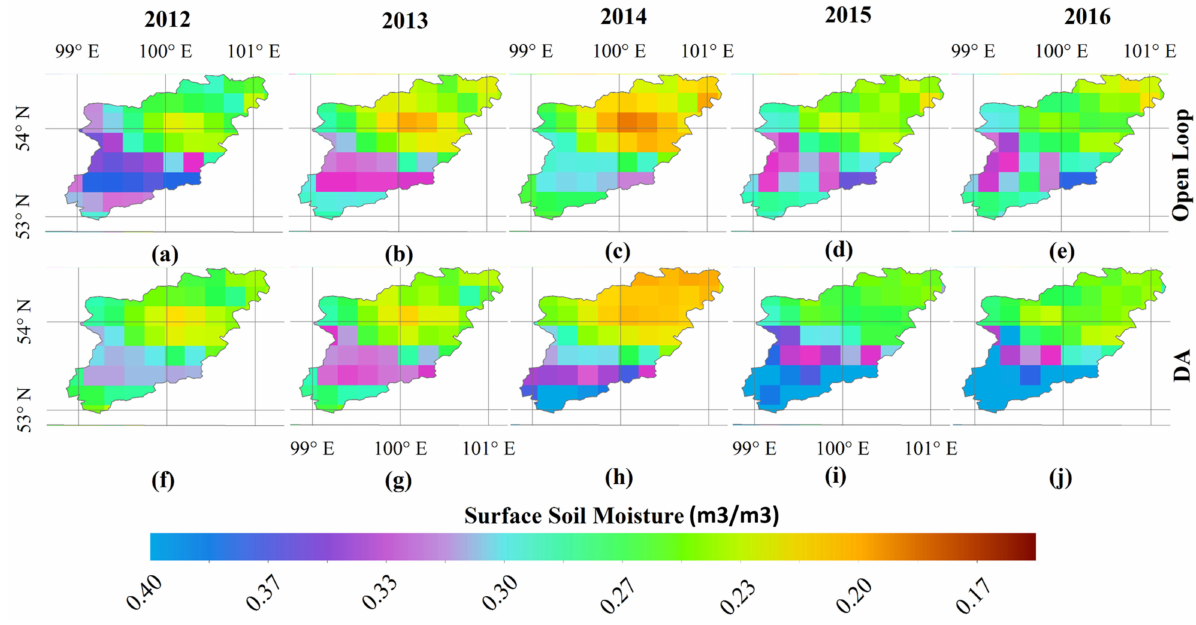
Figure 6. Represents spatial pattern of SM over the Iya Basin during summer season. Annual mean from open loop are shown in top row ( a – e ), from DA in bottom row ( f – j